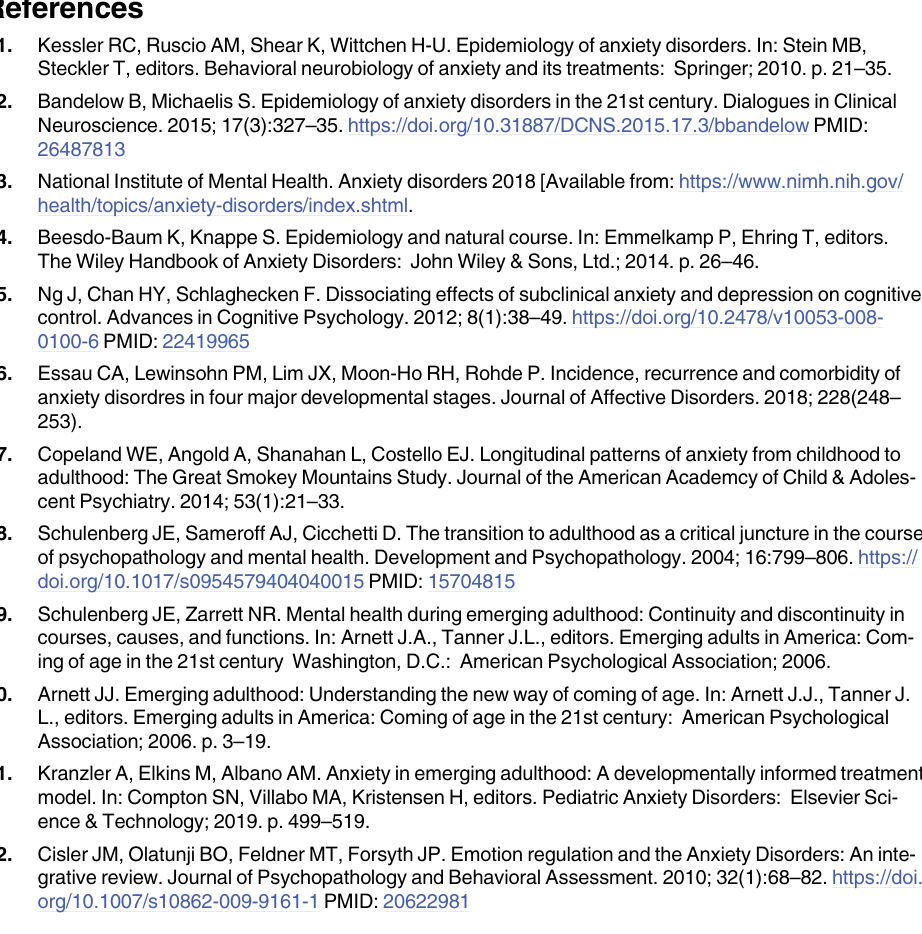
S1 Table. Unstandardized, standardized, and significance levels for the